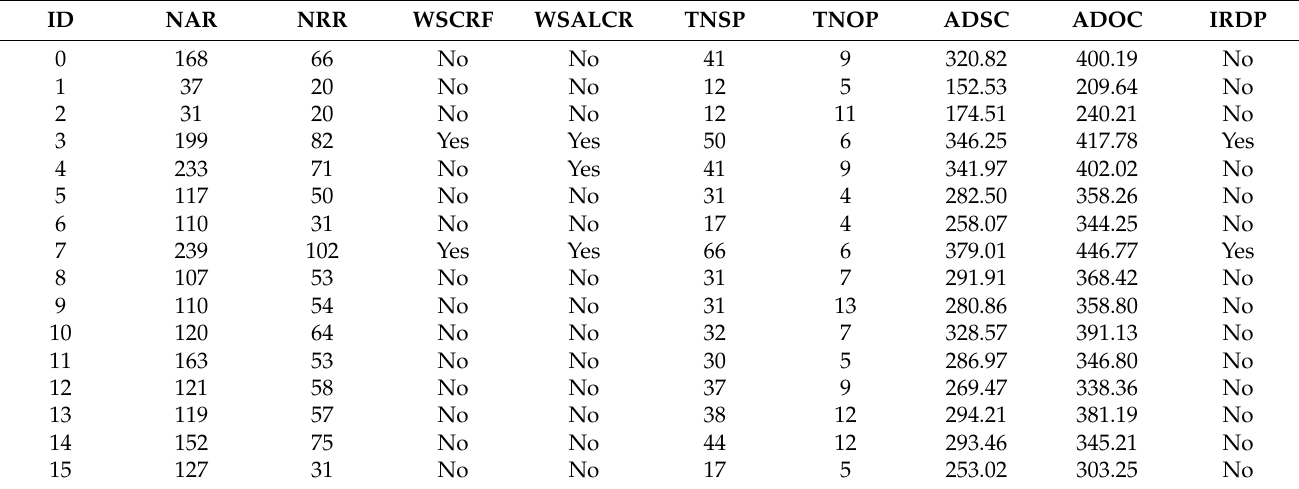
Table 2. Drainage features of identification units.